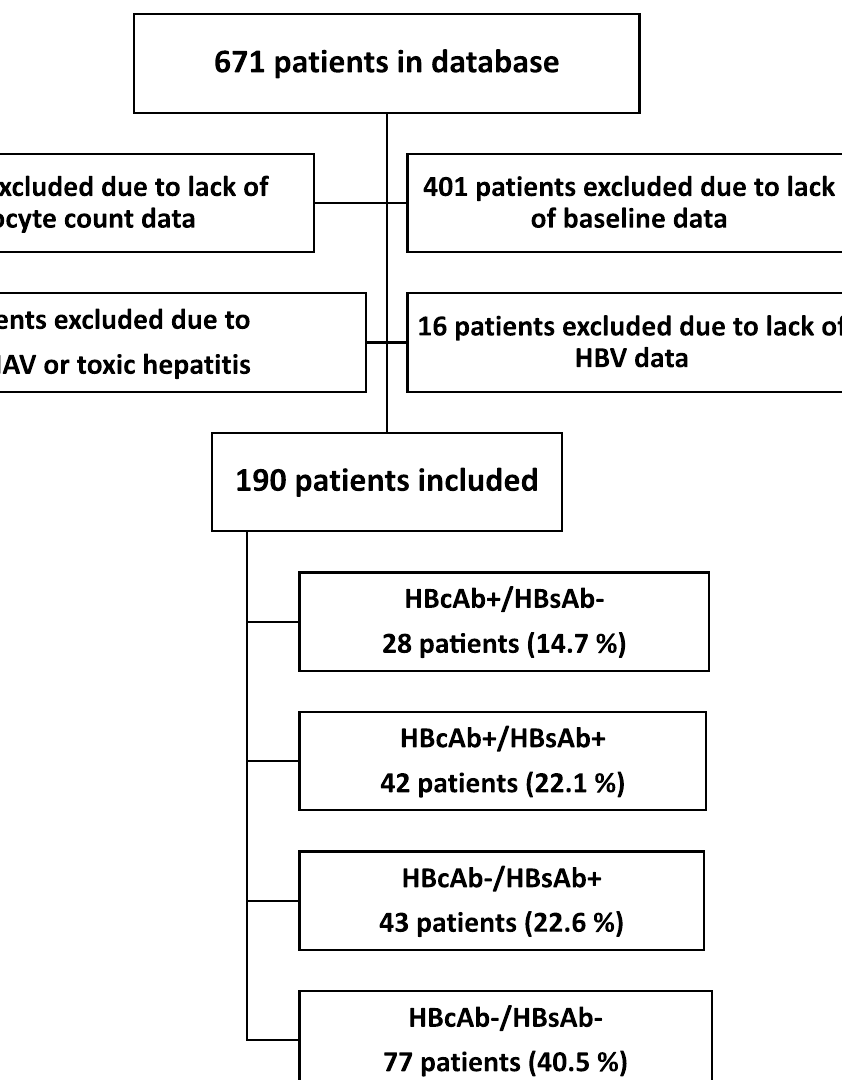
Figure 1. Study population inclusion and exclusion criteria